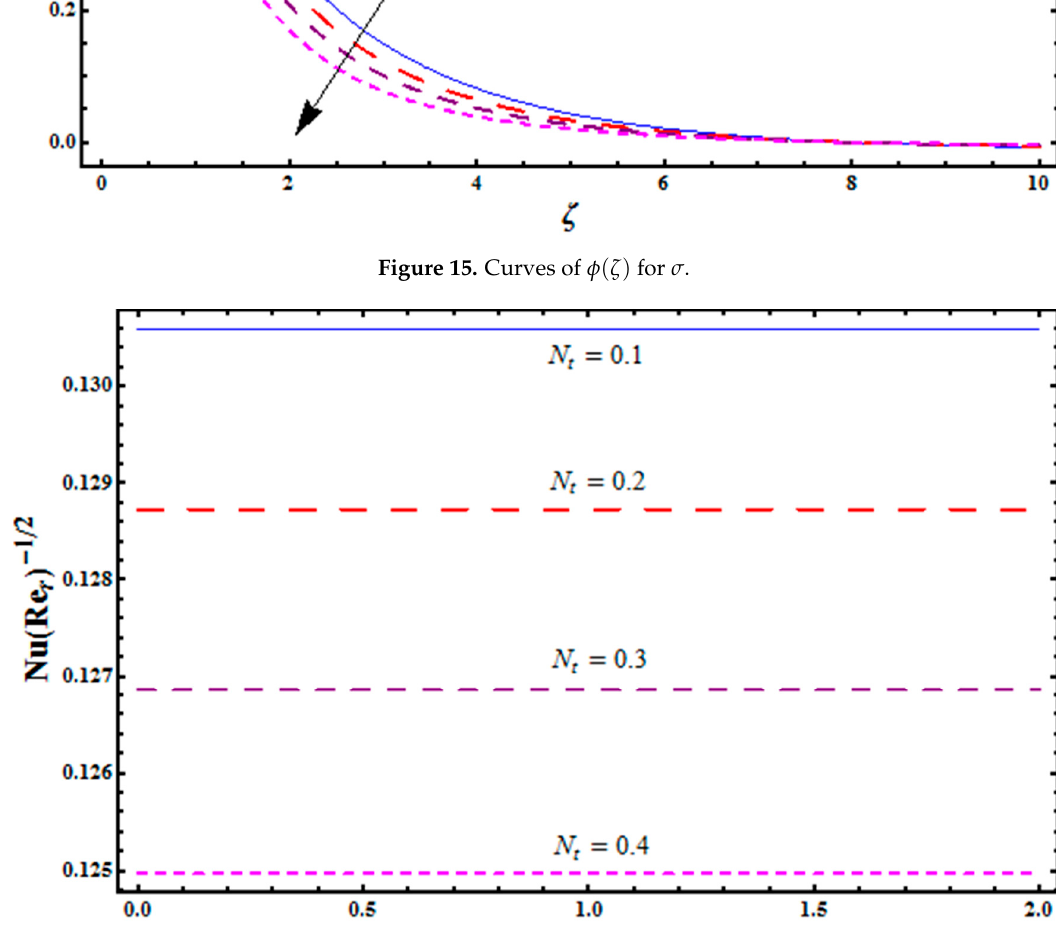
Figure 16. Curves of Nu ( Re r ) − 1/2 for N t